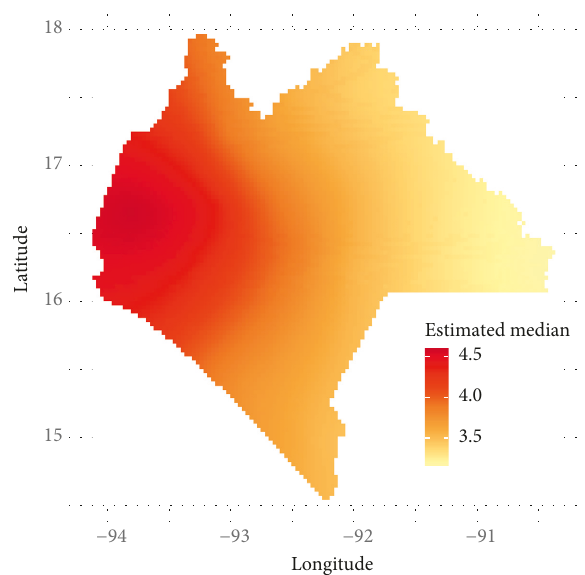
Figure 8: Interpolation of confirmed cases of